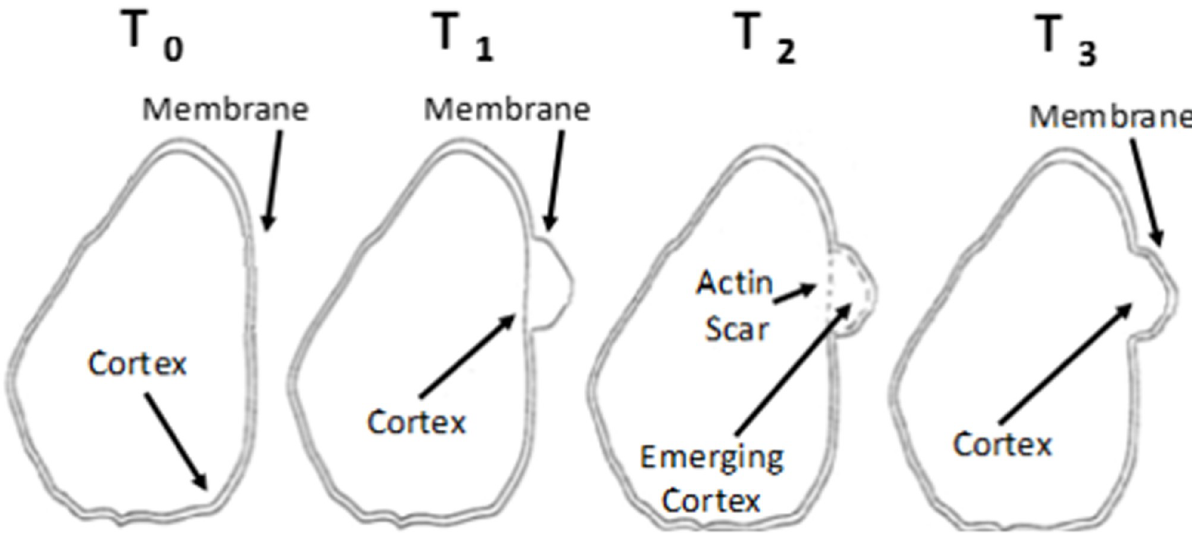
Fig 1. Bleb formation can be identified by cortex-to-membrane positioning. At T 1 , the membrane detaches from the cortex, initiating a bleb. At T 2 , an actin scar in the original location of the cortex disassembles as the cortex begins to reform at the new location of the membrane. At T 3 , the cortex is bound to the membrane in the